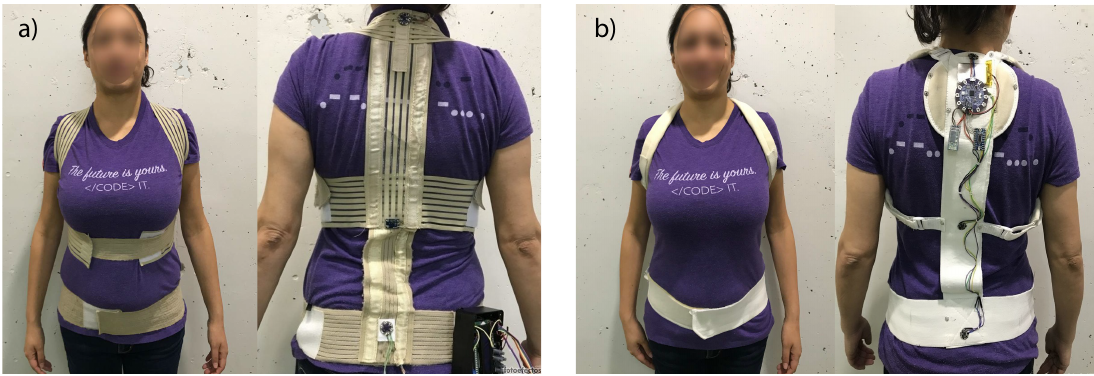
Figure 1. StraightenUp design: ( a ) phase I; ( b ) phase